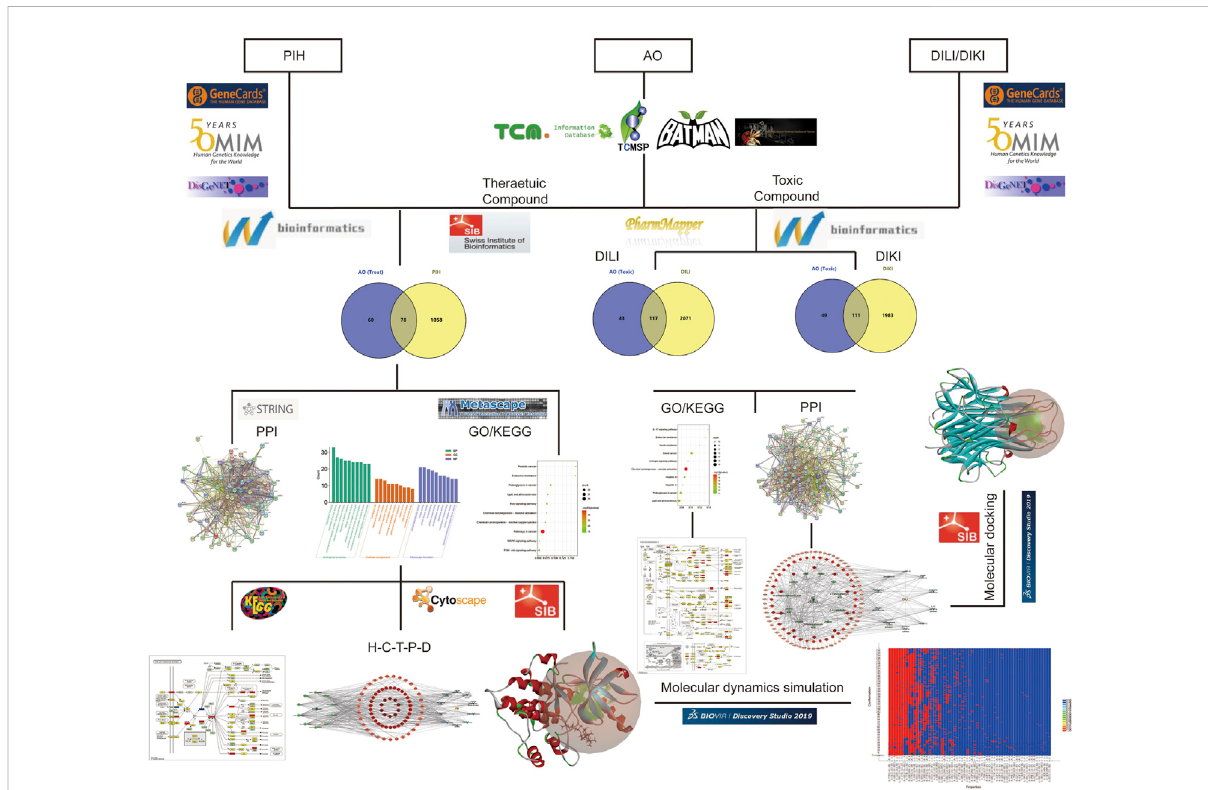
FIGURE 1 The fl owchartofthisstudytoexplorethepotentialmolecularmechanismofAOinthetreatmentofPIHandtoxiccompoundsinducedhepato-